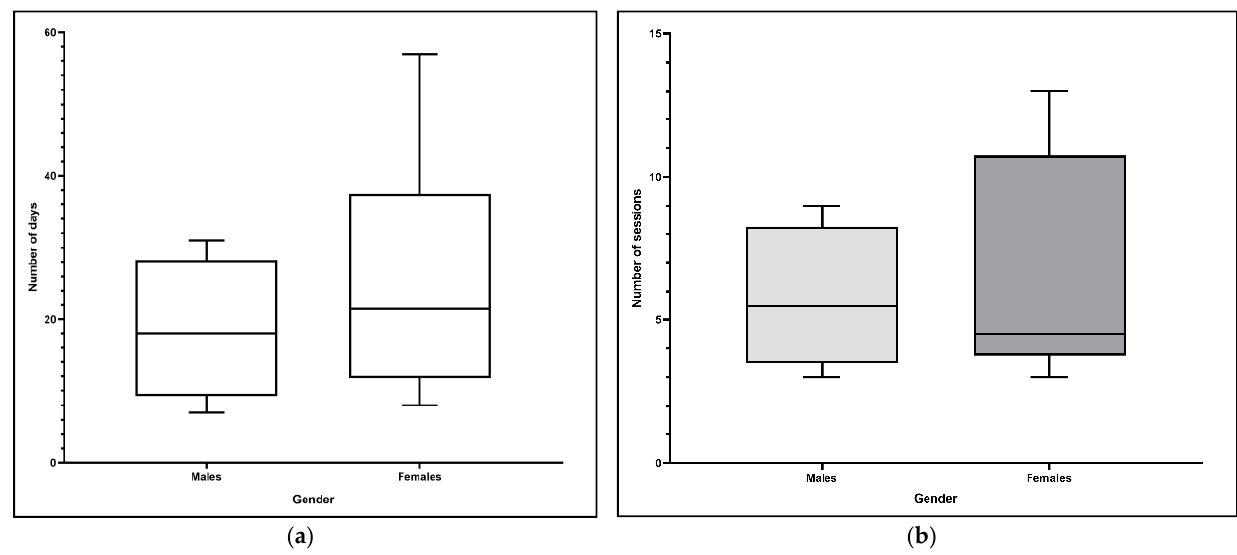
Figure 1. ( a ) Influence of gender on the number of days until lameness recovery ( p = 0.81). ( b ) Influence of gender on the number of therapy sessions until lameness recovery ( p = 0.99).